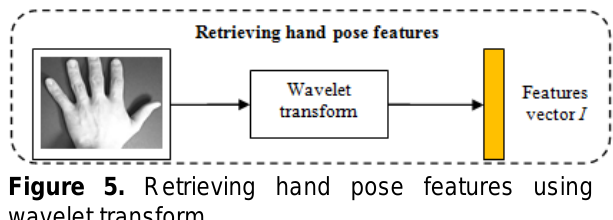
Figure 5. Retrieving hand pose features using wavelet